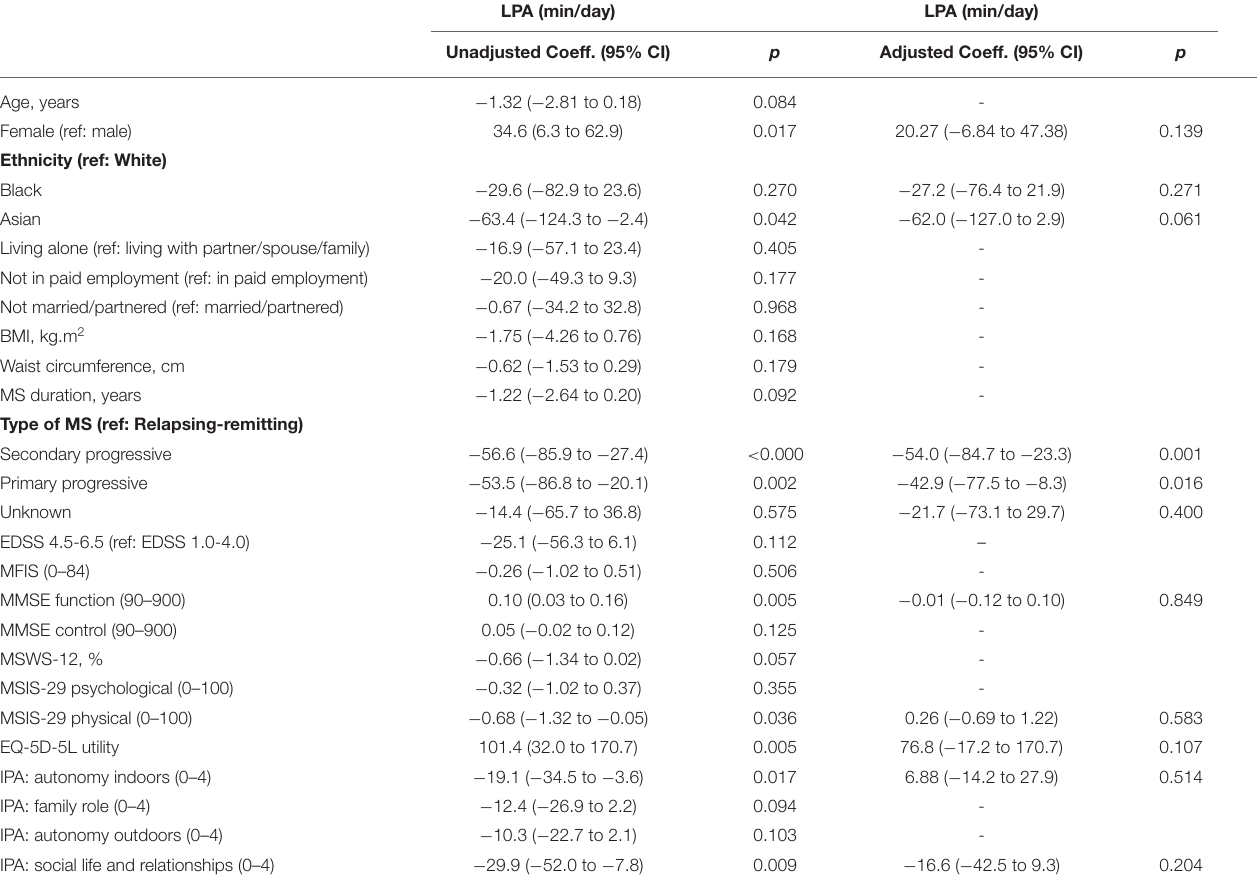
TABLE 3 | Associations between demographic, clinical characteristics, and light physical